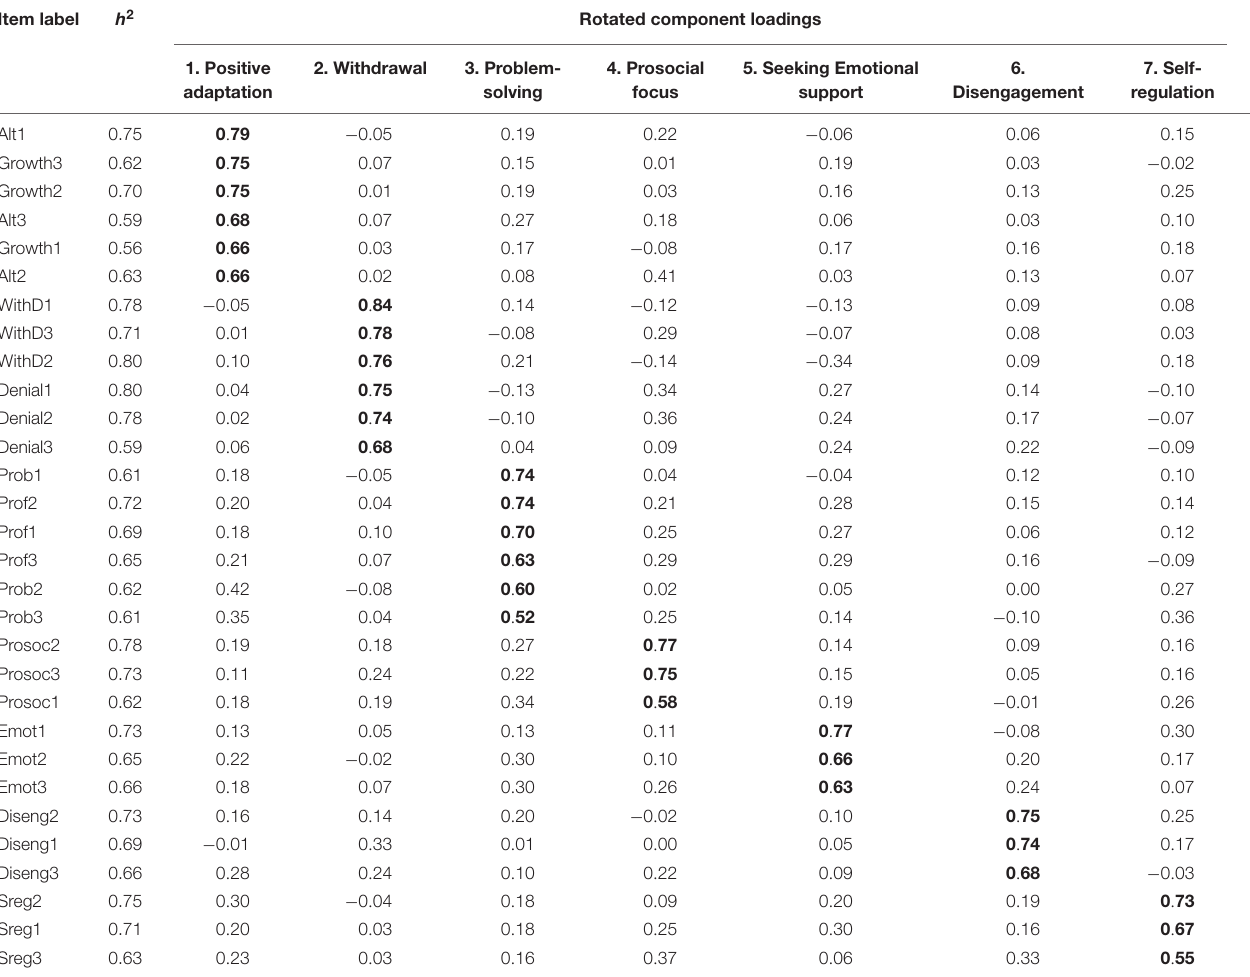
TABLE 2 | Communalities and rotated factor loadings for the coping strategies scale (CSS) (Group A data, n = 367). Item label h 2 Rotated component